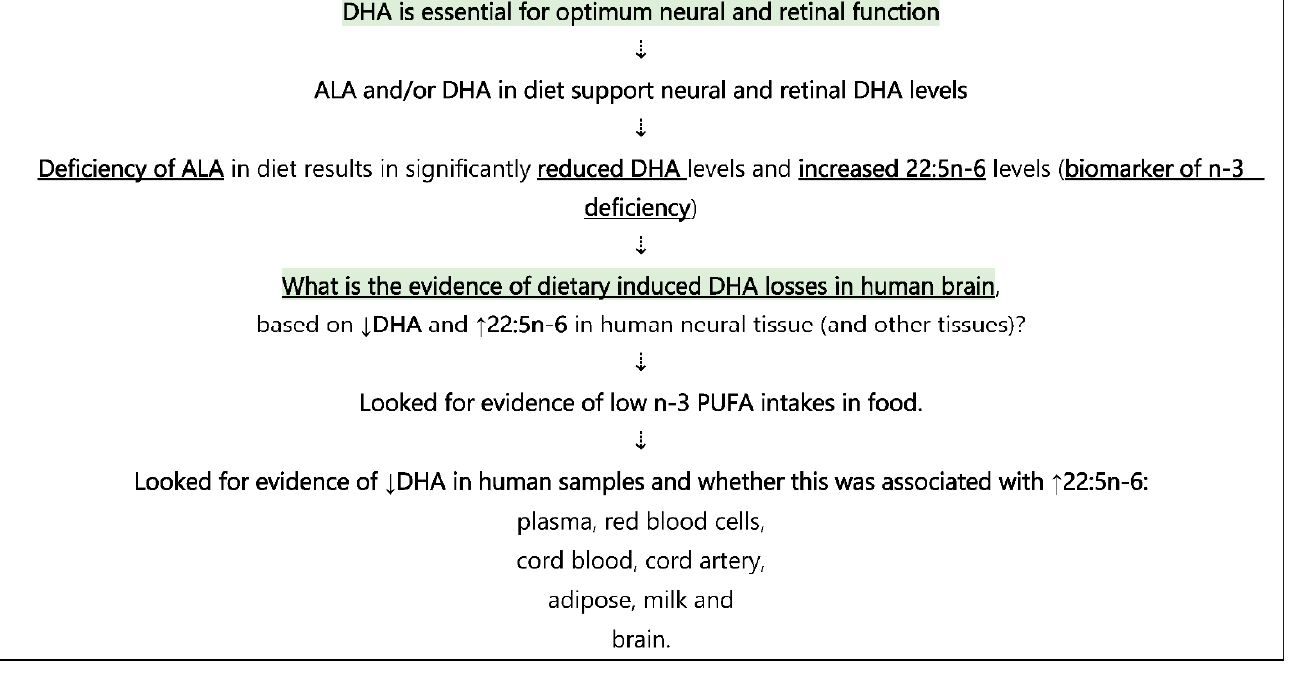
Figure 2. Strategy and logic of the data presented in this paper.